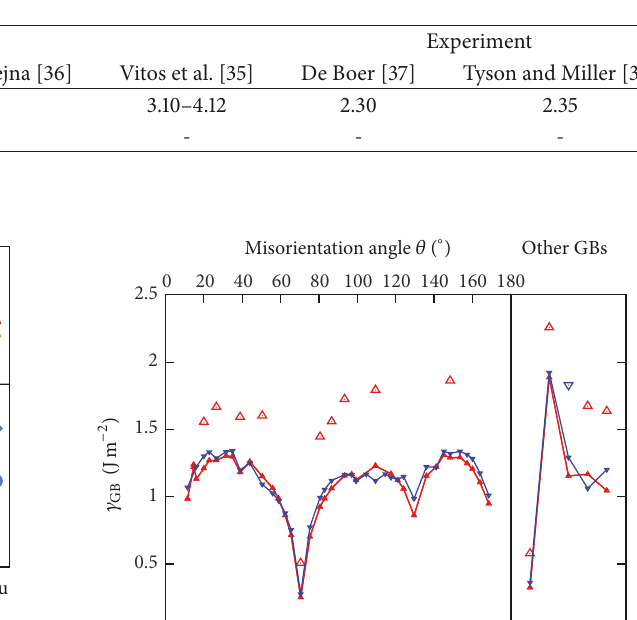
Table 1: The (210) free surface 𝛾 FS 0 and the Σ 5 (210) [100] GB 𝛾 GB 0 energies of pure Cr in J/m 2 . The results are compared to DFT data from [31, 35, 36] and experimental data from [37, 38].